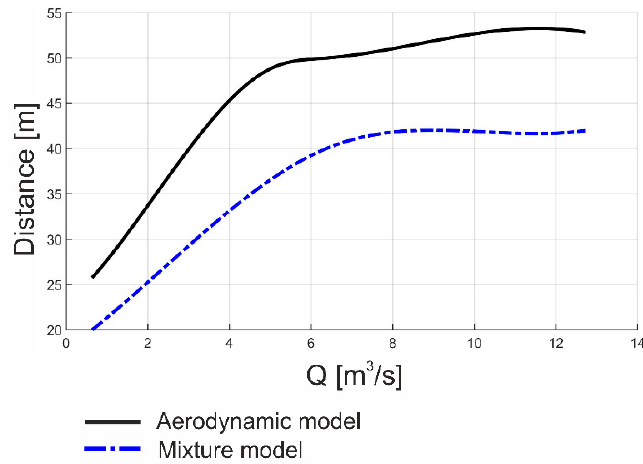
Figure 14. Maximum possible duct end-to-face distance for some ventilation of the dead zone, obtained with the aerodynamic and mixture models.